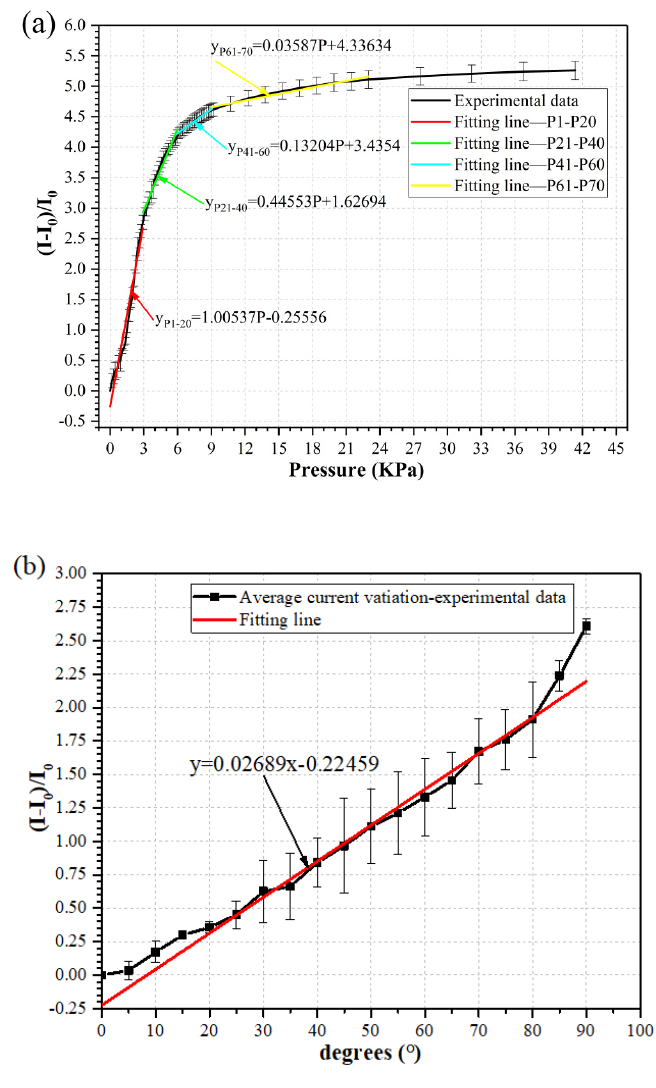
Figure 5. Electromechanical properties of the piezoresistive element under ( a ) pressure mode; ( b ) bending mode.